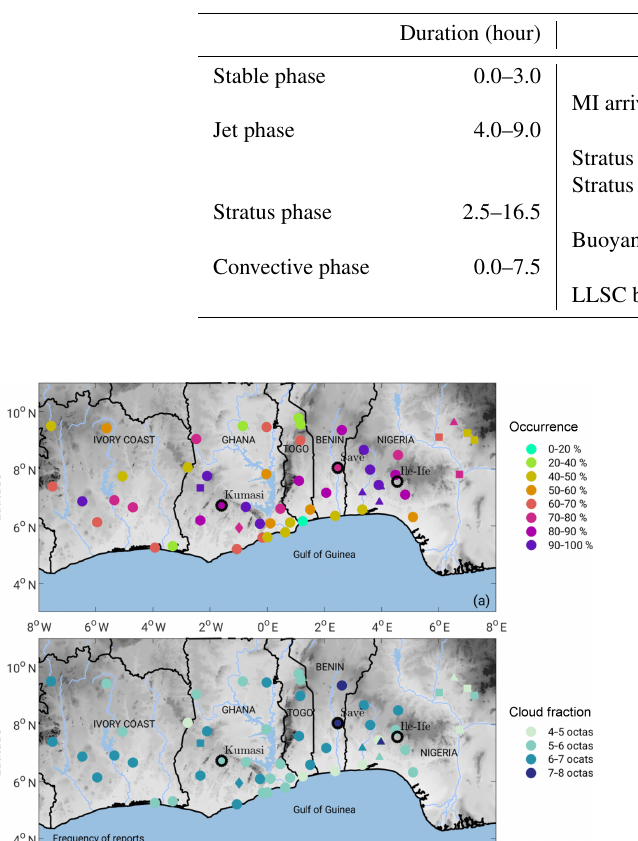
Table 1. Variation in the duration of the four phases and variation range of MI arrival, stratus fractus, and stratus onset and breakup times for the 11 IOPs included in the statistics for Fig. 3.